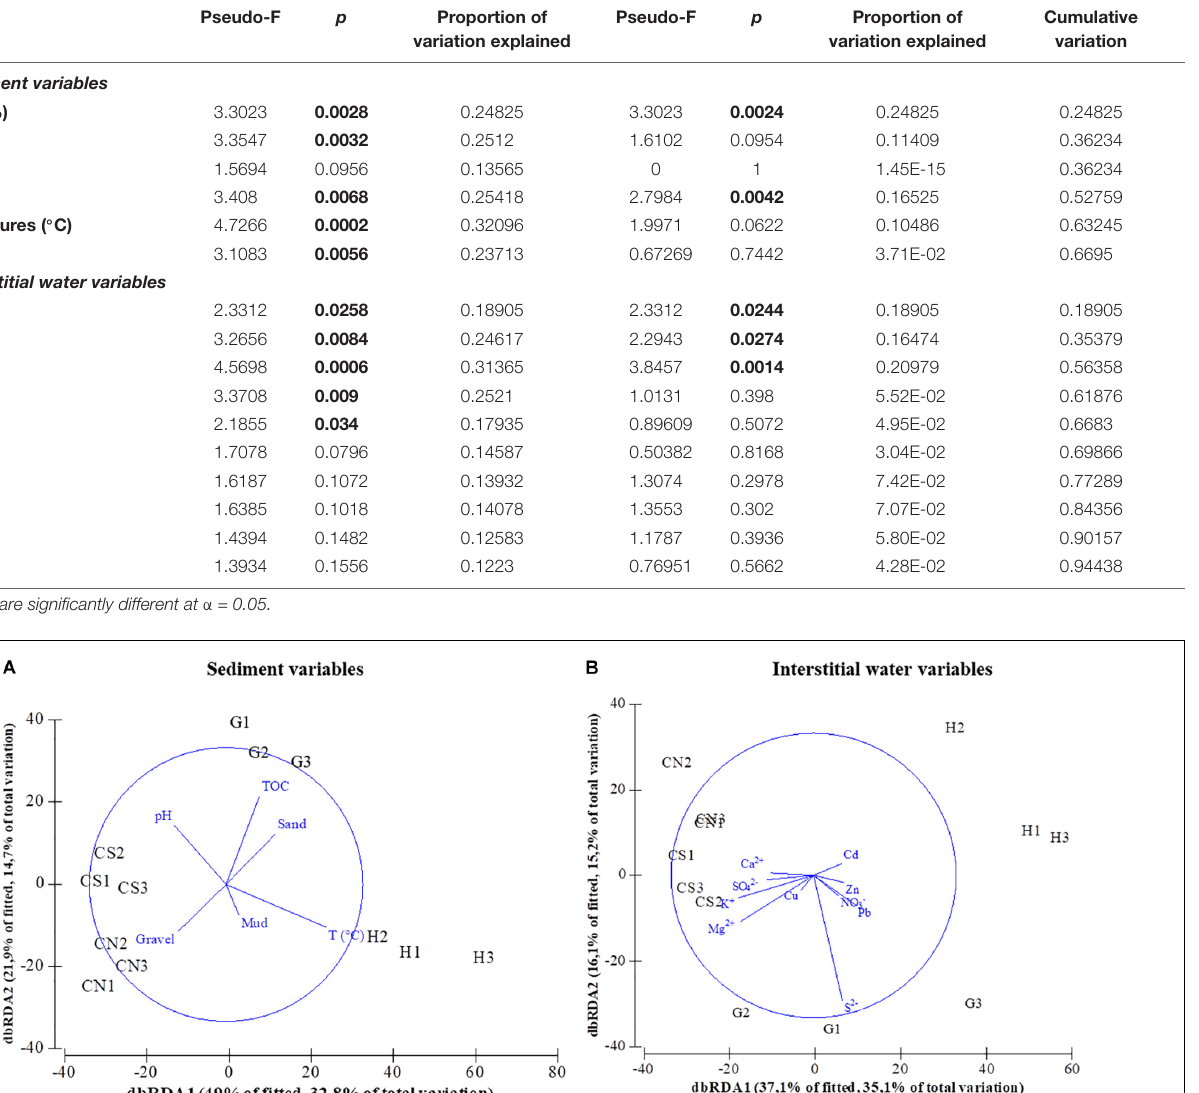
the bivalves H. arctica and Venus verrucosa , the